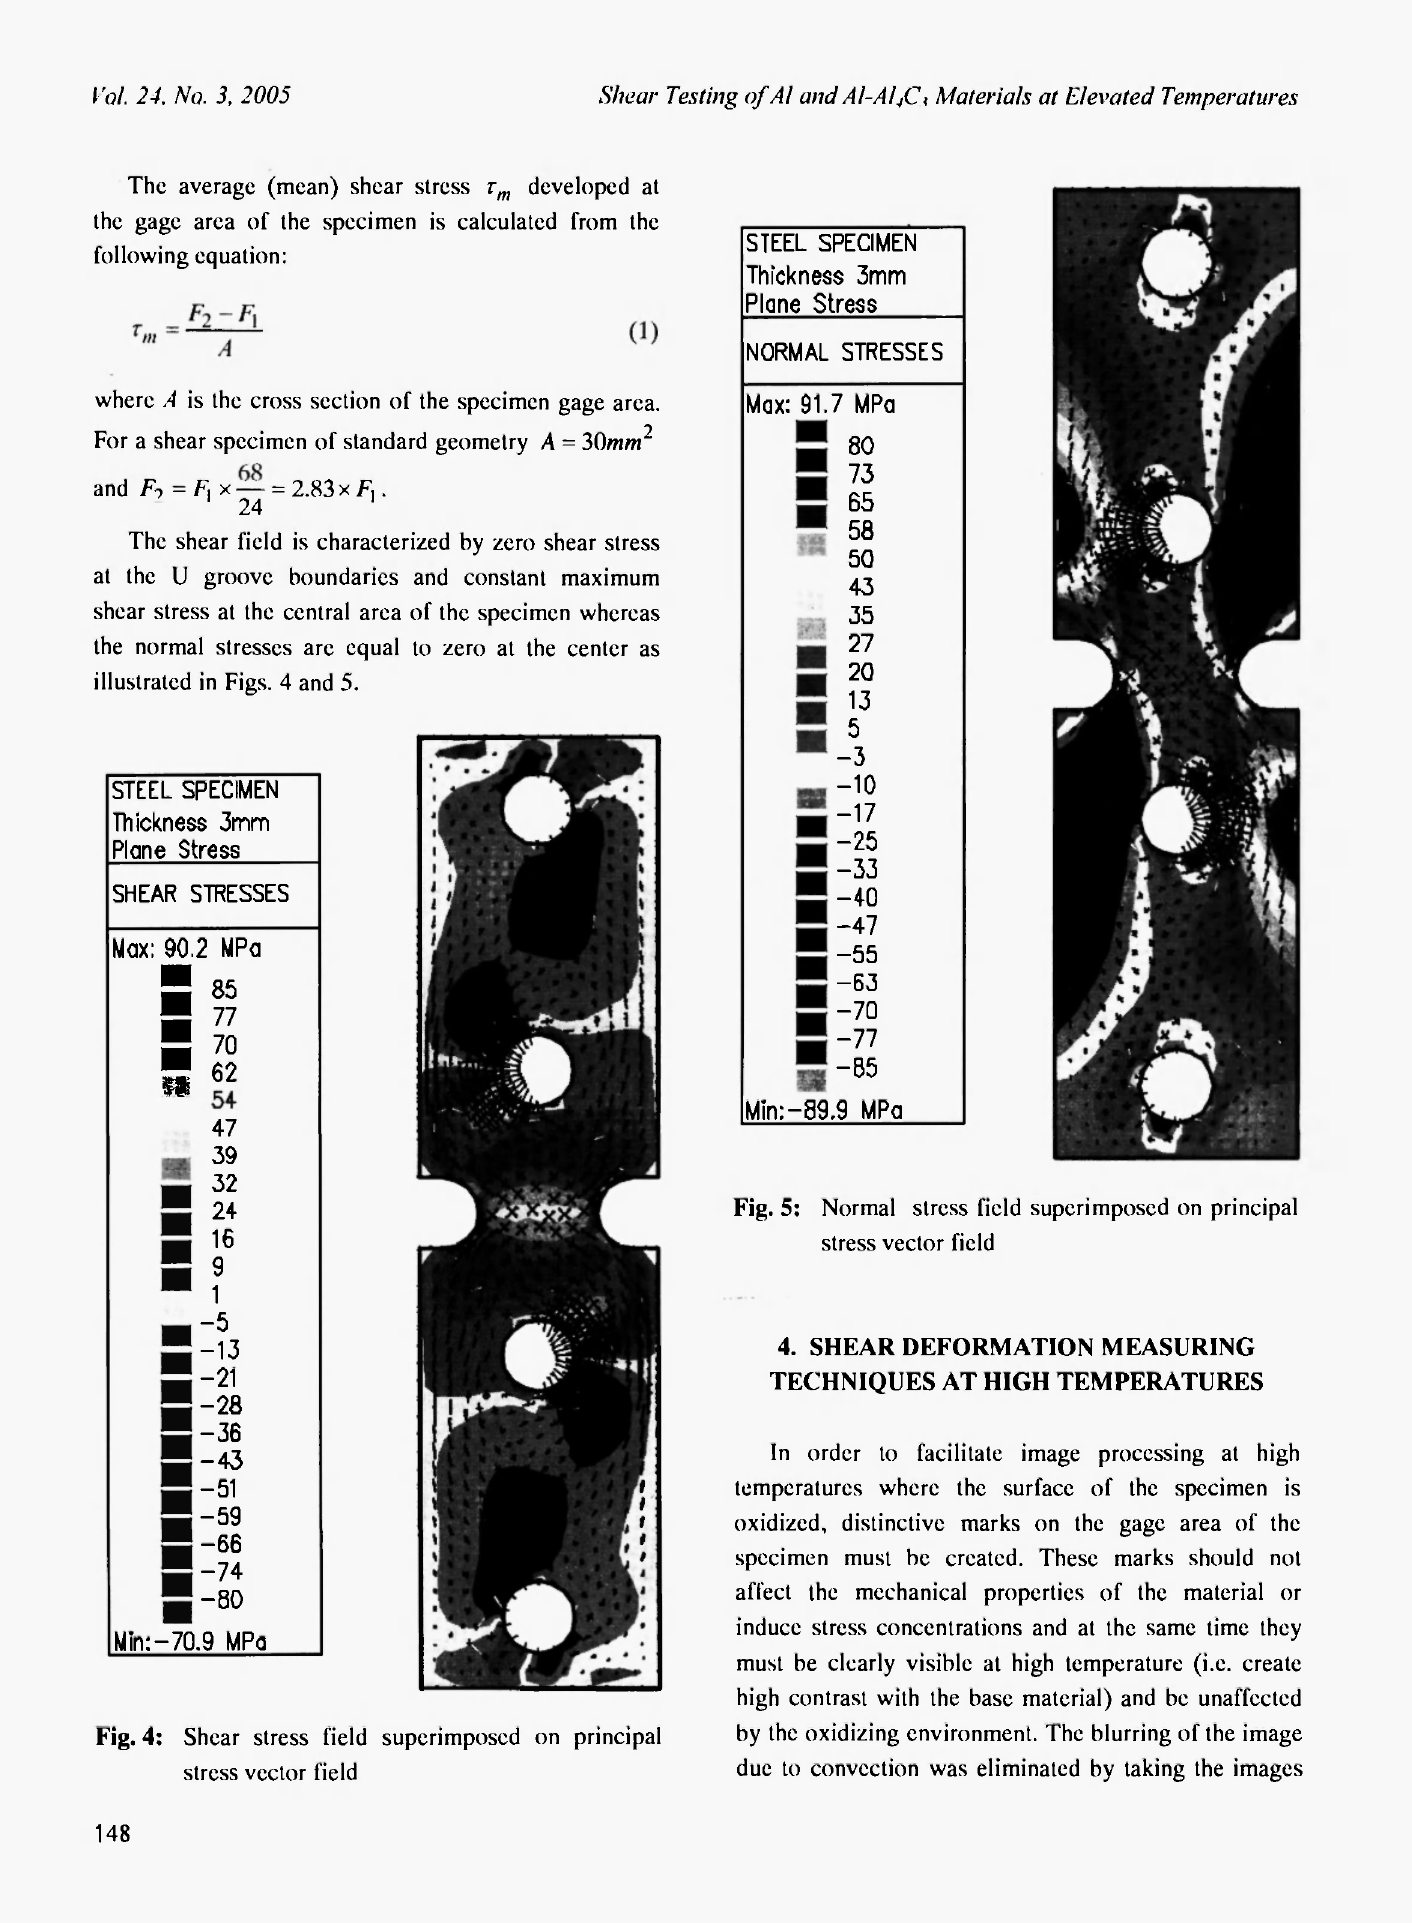
4. SHEAR DEFORMATION MEASURING TECHNIQUES AT HIGH TEMPERATURES